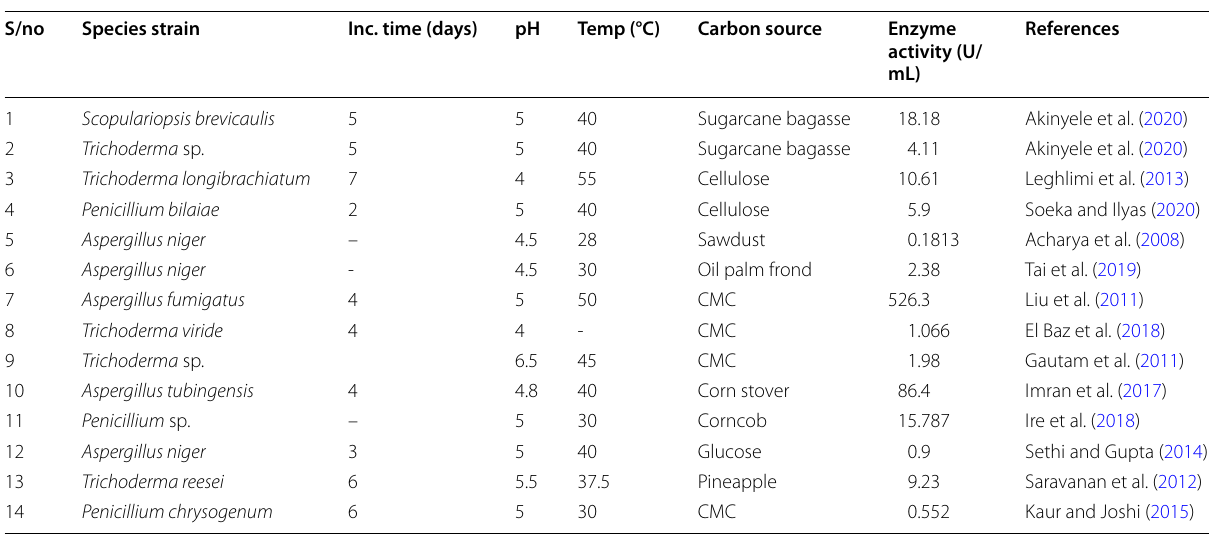
Table 2 Some cellulase-producing fungi species